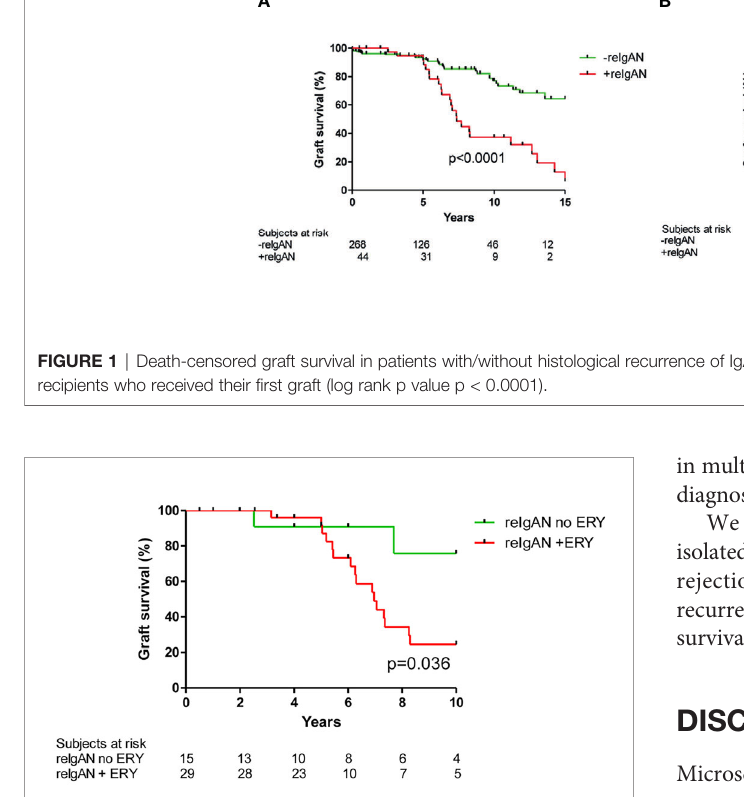
FIGURE 2 | Death-censored graft survival in patients with histological recurrence of IgAN with/without microscopic hematuria. Patients with both reIgAN and microscopic hematuria had worse graft survival (log rank p value=0.036). ERY, microscopic hematuria; reIgAN, recurrence of IgAN.